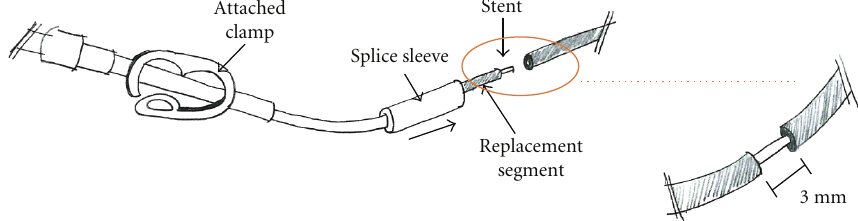
Figure 1: Attachment of external segment.